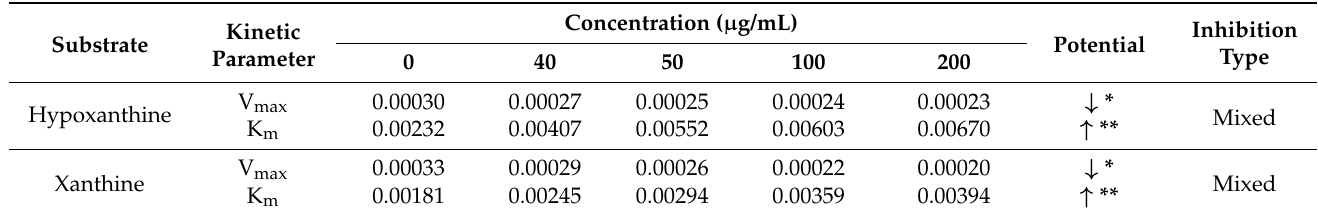
Table 6. Kinetic parameters of limonene against xanthine oxidase in enzyme kinetic